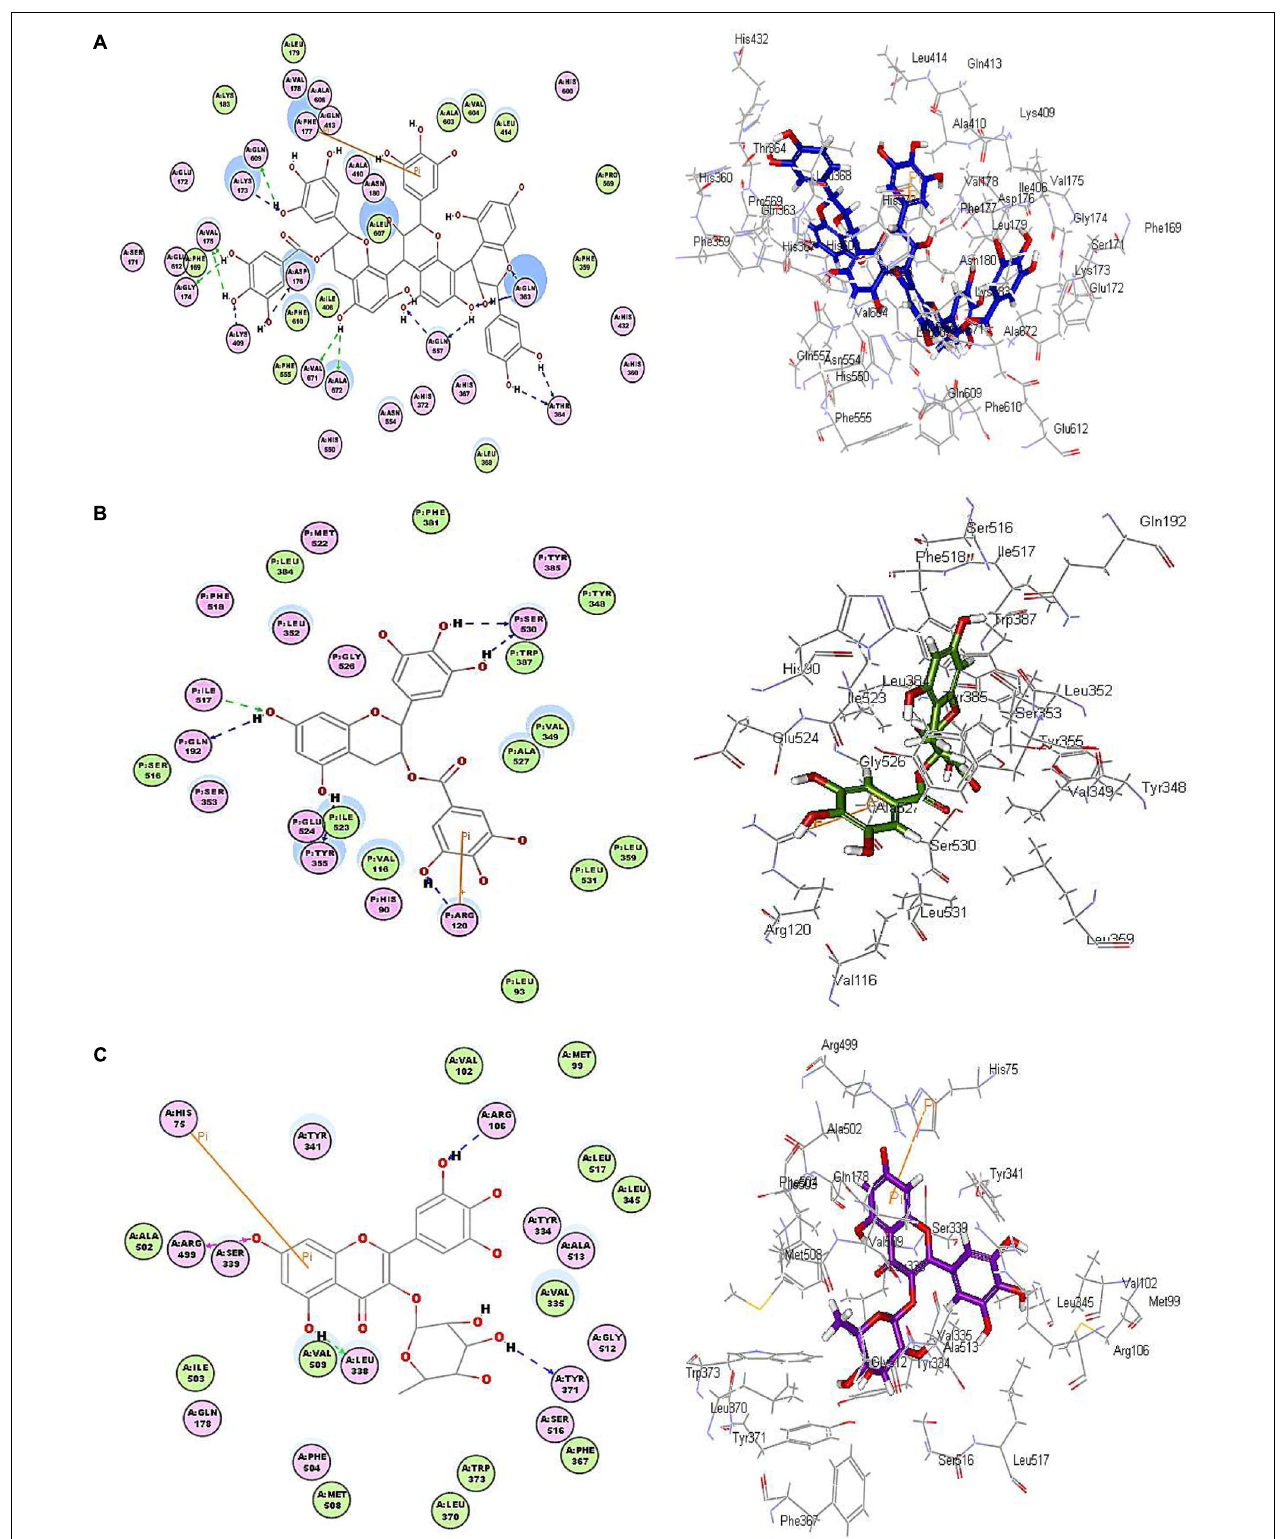
FIGURE 8 | 2D and 3D binding mode of (A) epicatechin-epigallocatechin-epigallocatechin gallate in 5-LOX, (B) epigallocatechin gallate in COX-1, (C) myricetin rhamnoside in COX-2 active sites using molecular modeling experiments applying pH-based ionization method.